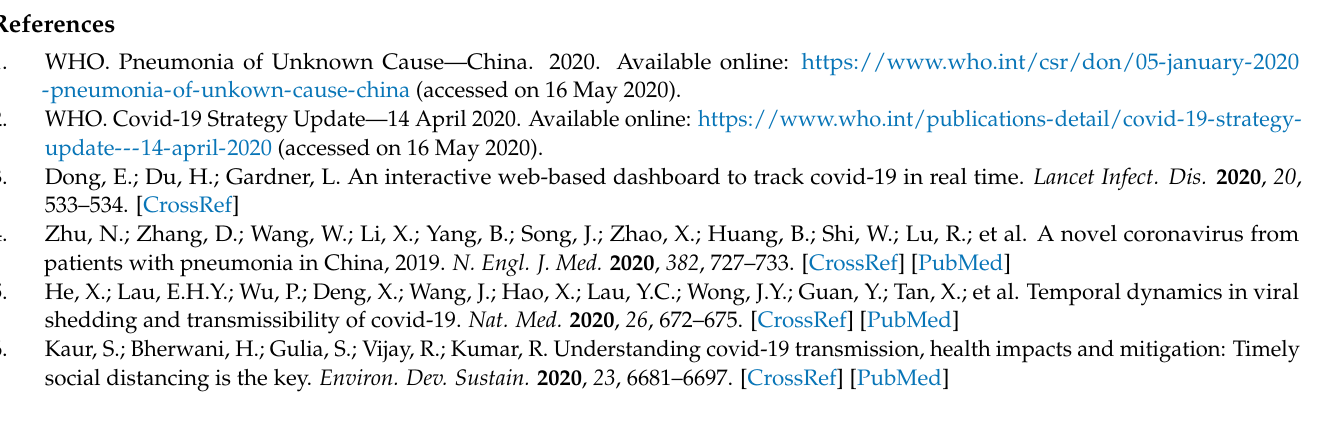
Table S2: Limit of detection LOD95% of the protocols used in this study as determined based on two distinct preparations of culture-grown